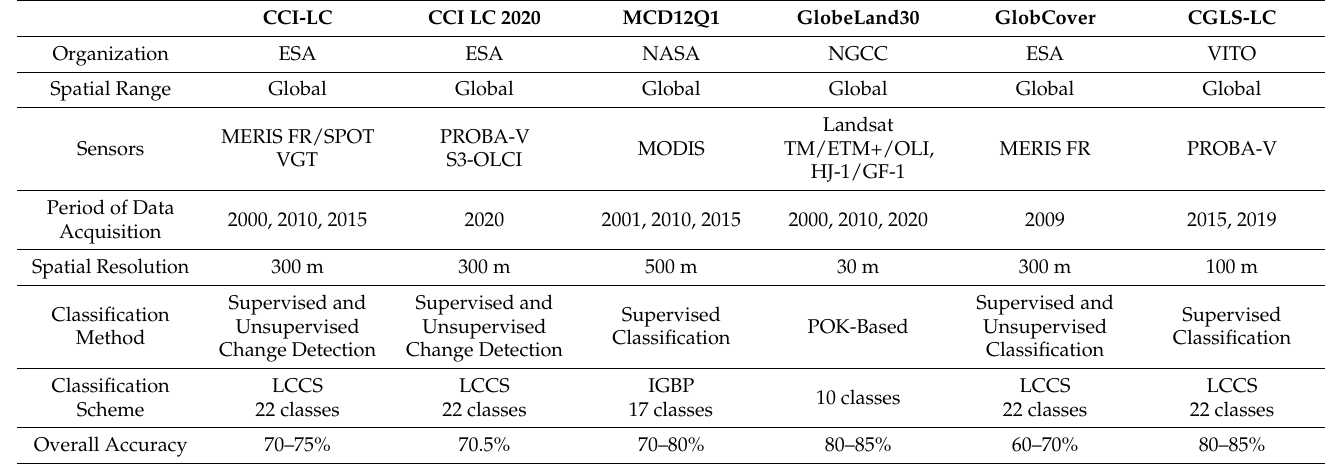
Table 1. Summary of the five global land cover datasets assessed in this